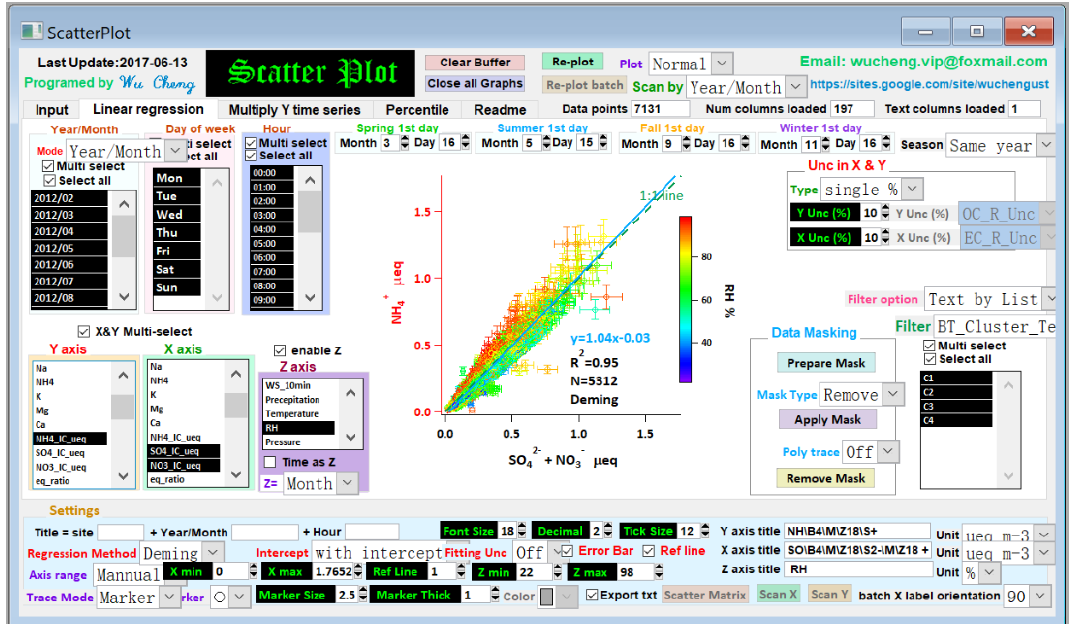
Figure 8. The user interface of the Scatter Plot Igor program. The program and its operation manual are available from https://doi.org/10.